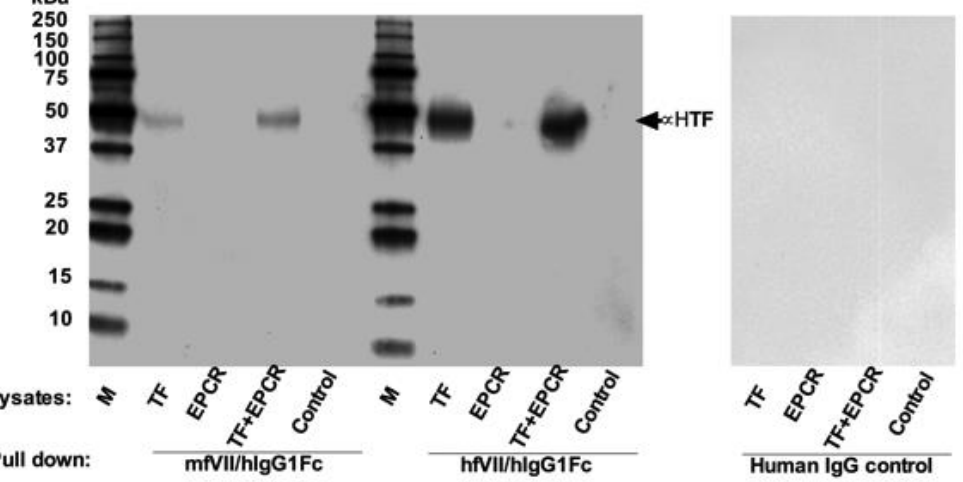
Figure 2. Tissue factor (TF) is the therapeutic target for fVII-targeted immunoconjugate (ICON). Representative Western blots using mouse ICON (mfVII/hIgG1Fc, an immunoconjugate of murine fVII fused to the Fc domain of human IgG1, called an ICON) and human ICON (hfVII/hIgG1Fc, human fVII fused to human IgG1 Fc immunoconjugate) to immune-precipitate their cognate receptor TF that was detected by monoclonal antibody against human TF (HTF) (clone HTF1). Note that both mouse and human ICONs contain a coagulation active site mutation (K341A) in their fVII peptides. The negative controls were untransfected Chinese Hamster Ovary (CHO-K1) cells. Human IgG was an isotype control. Cell lysates were derived from CHO-K1 cells expressing tissue factor (TF), endothelial protein C receptor (EPCR) or both (TF + EPCR). Modified from ref. [15].